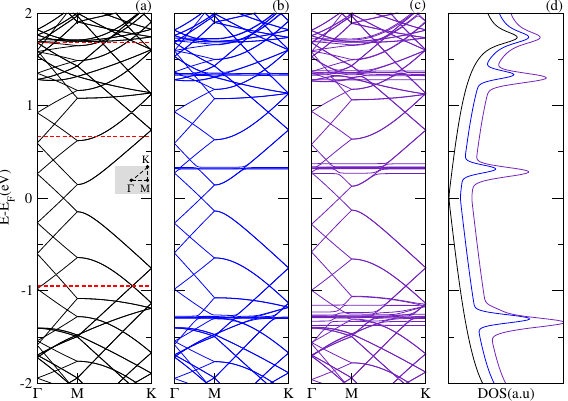
Figure 1. Electronic band structure of ( a ) a supercell of a graphene monolayer; the red line dash represents the energy levels of isolated C 60 ; ( b ) a C 60 fullerene physisorbed onto the supercell of a graphene monolayer and ( c ) two C 60 fullerenes physisorbed onto the supercell of a graphene monolayer; Panel ( d ) shows the total density of states.